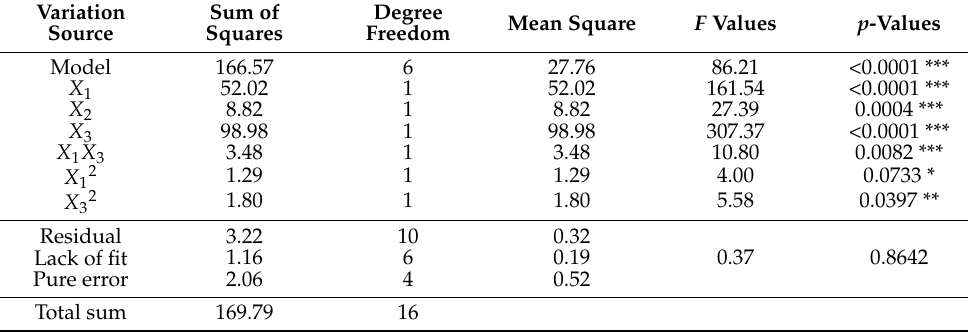
Table 4. Experimental design and results.